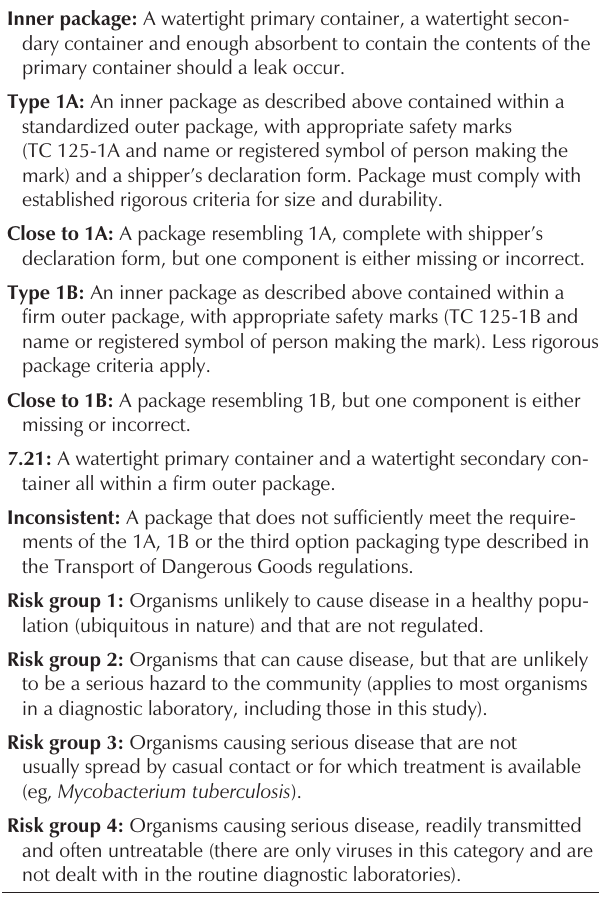
Glossary of terms used in study of packaging used for transport of biological samples